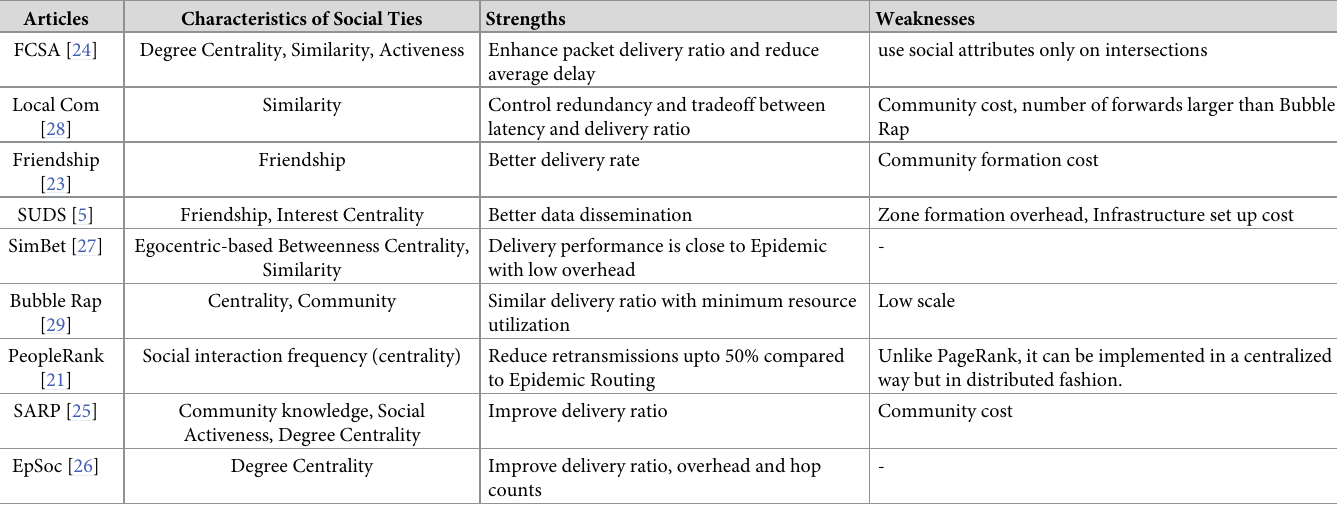
Table 1. Summary of social metrics-based DTN routing